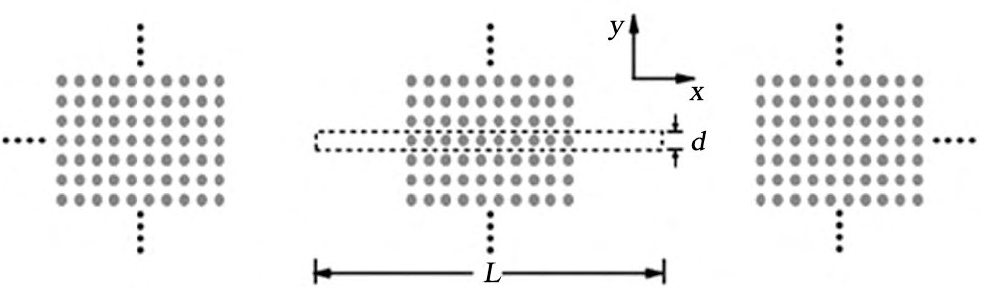
Figure 22. ( a – c ) Evolution of a floating double resonator to a thin film structure; ( d ) Negative mass density system; ( e ) Amplified evanescent wave [77].